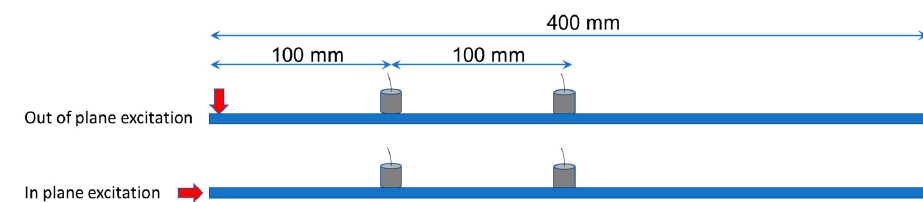
Figure 3. Schematic representation of the AE measurements with pencil lead break excitation.